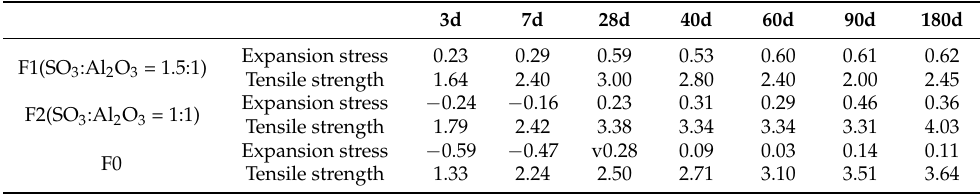
Figure 7. Content of ettringite of samples. Table 5. Expansion stress and tensile strength of specimens.